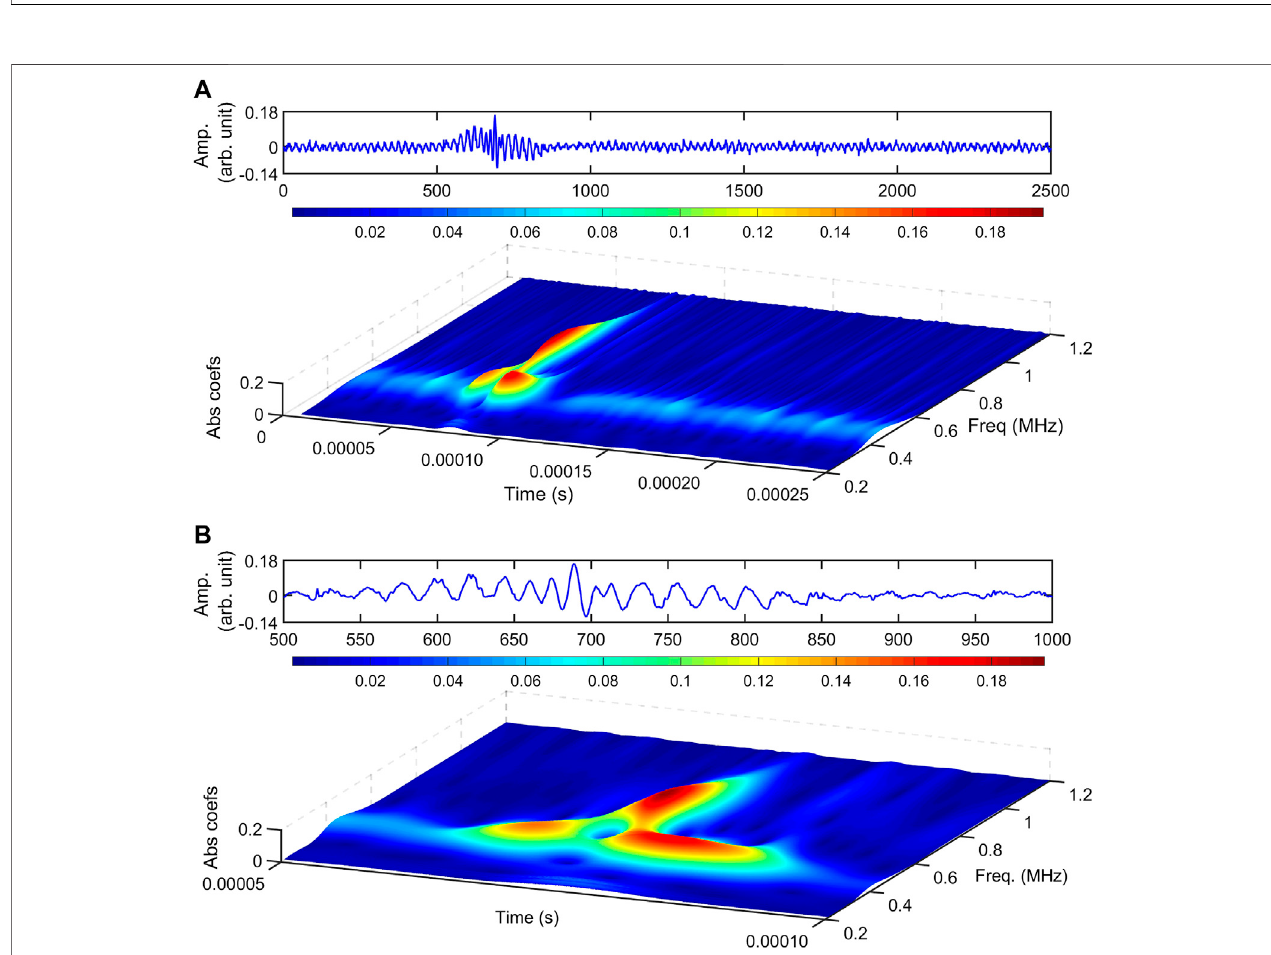
FIGURE 7 | Typical CWT scalogram of fundamental Peregrine soliton without application of V HF . The probe position is at 9 cm. (A) Time series (top) and CWT scalogram (bottom) for Peregrine soliton f or data length 0 – 250 µs. (B) Enlarged view of (A) for data length 50 – 100 µs.